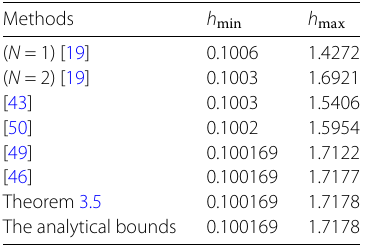
Table 4 Delay interval which stability of system in Example 4.4 is